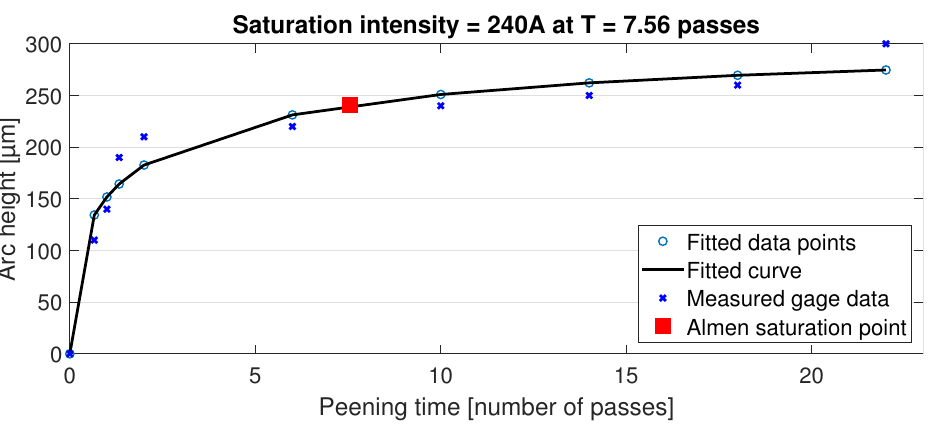
Figure 2. Almen intensity